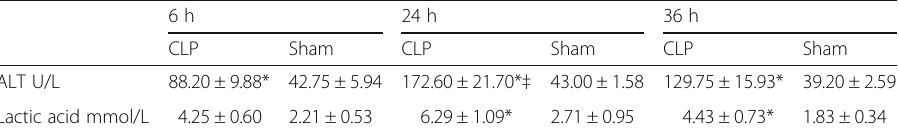
Table 1 Plasma alanine amino transferase (ALT), and lactic acid in control and CLP groups over time. Results are means ±